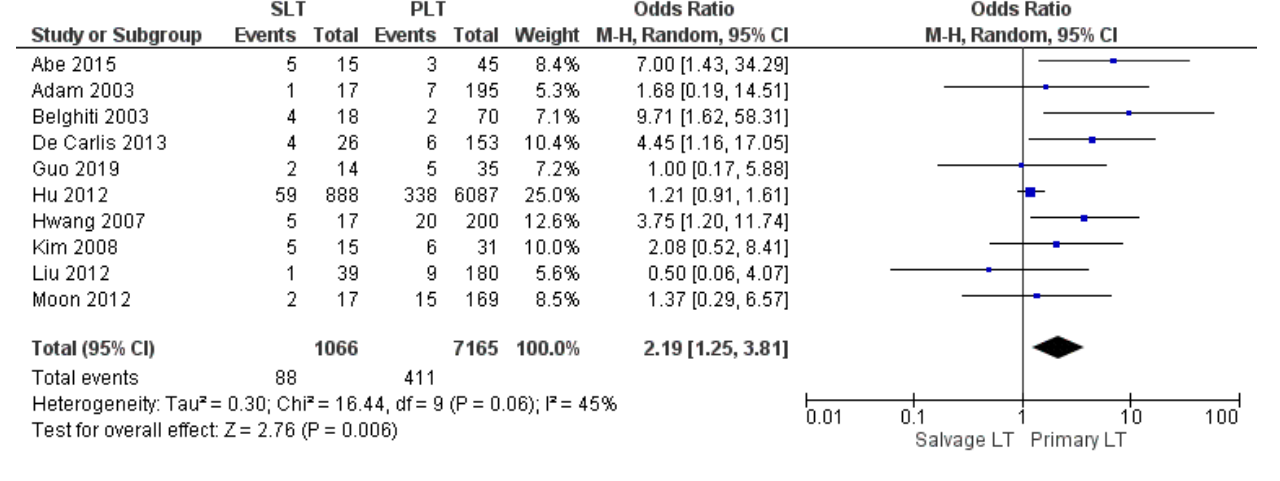
Figure 9. Postoperative bleeding.